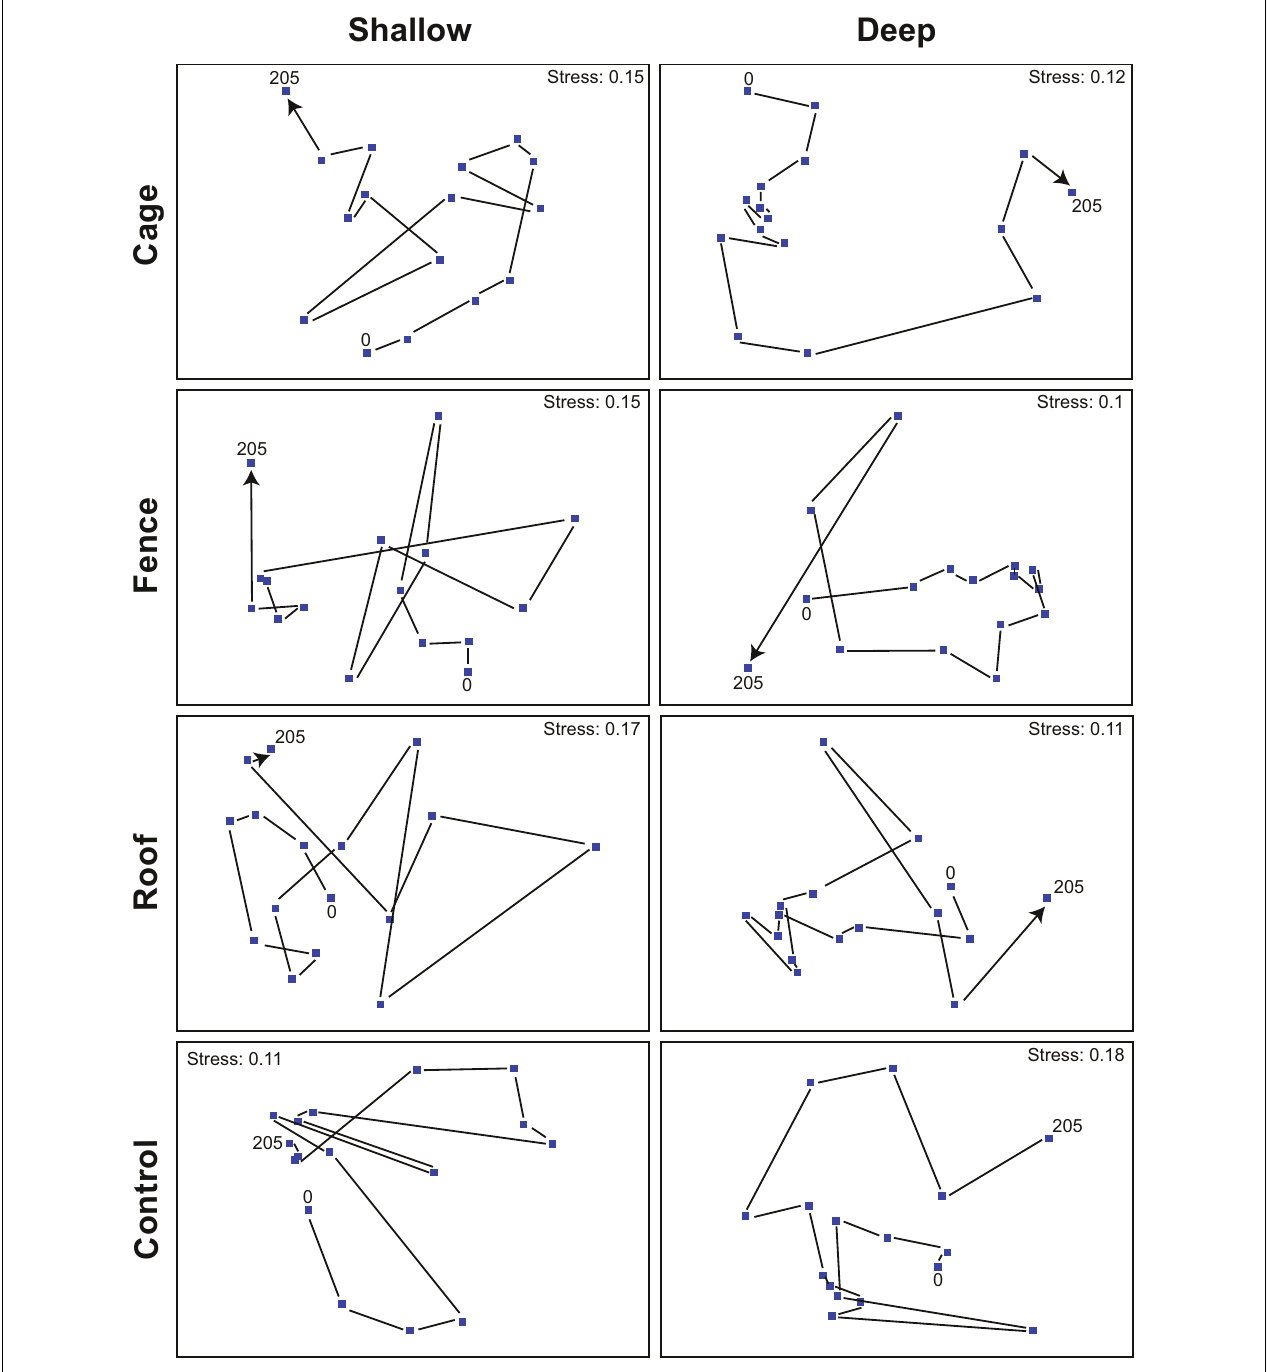
FIGURE 3 | Temporal variation of substrate cover (second-stage NMDS) from exclusion experiments at Arraial do Cabo (RJ, Brazil). Numbers in the figures indicate time step associated with sampling events, and each dot represents the centroid of similarity matrices for different conjuncts of samples according to treatment and depth stratum. Cage = complete exclusion, Fence = sea urchin exclusion, Roof = herbivorous fishes exclusion, Control = no exclusion. Shallow = 1–2 m, Deep = 5–6